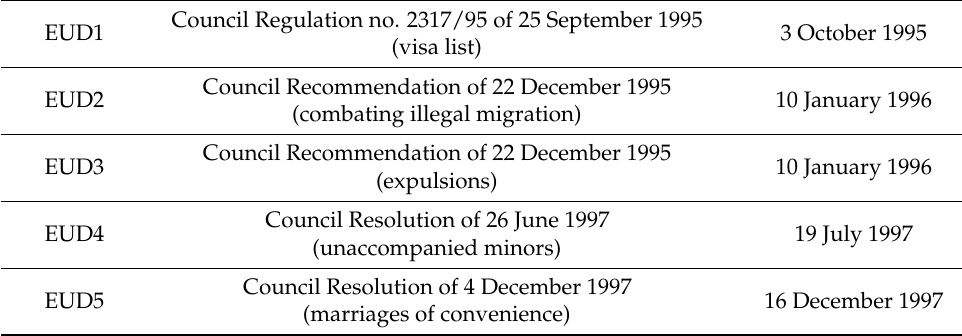
Table 1. Empirical documents, part 1